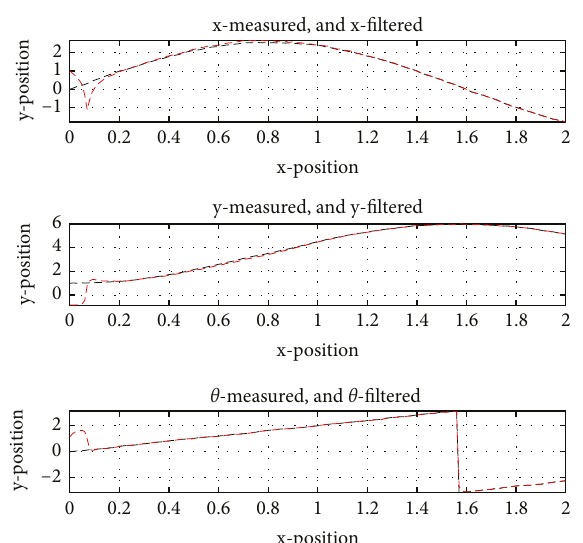
Figure 7: EKF performance with two landmarks and Gaussian noise.